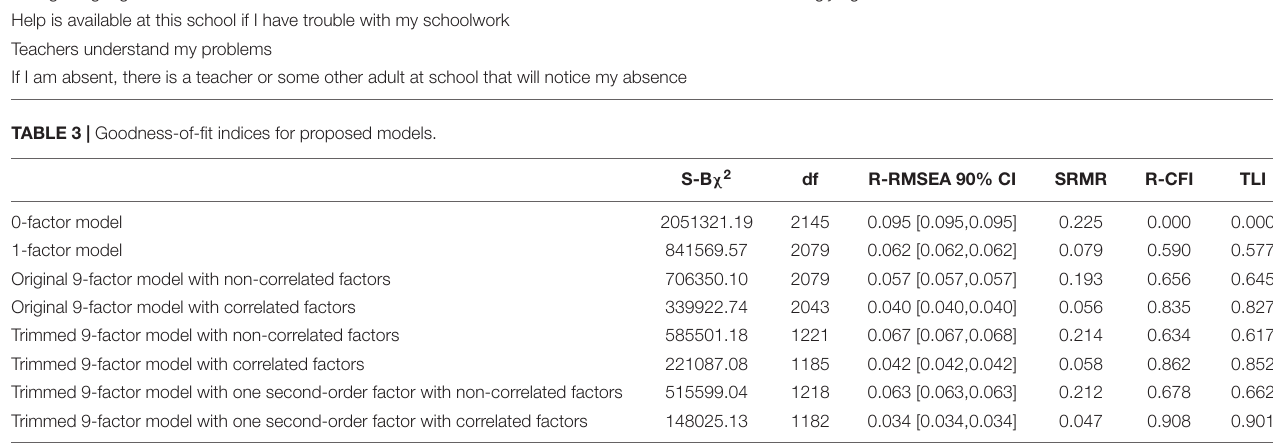
TABLE 4 | Goodness-of-fit indices for invariance of the trimmed model across gender. χ 2